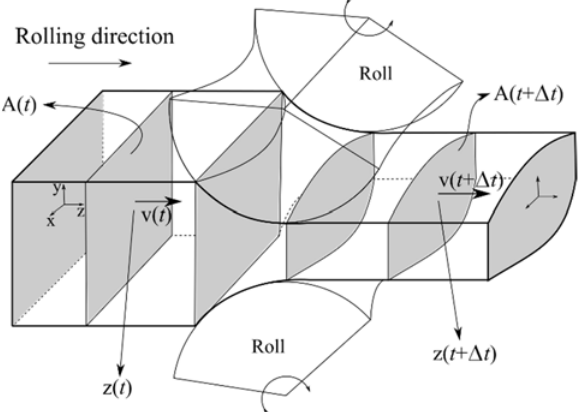
( ) ( ) A t is area, v t